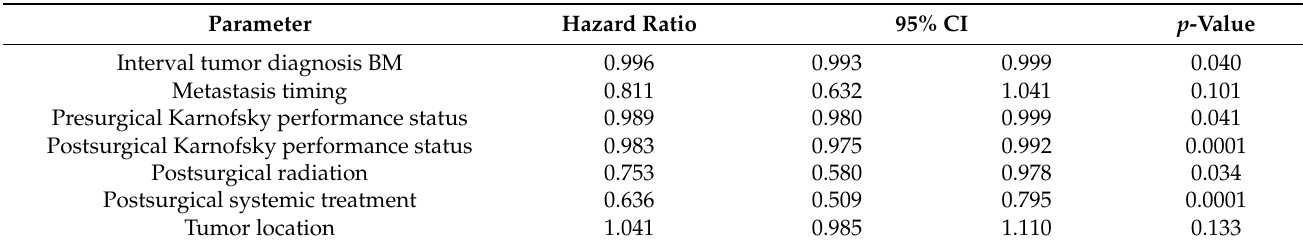
Table 4. Cox proportional hazard regression analysis shows pre and even more pronounced the postsurgical KPS, interval between tumor diagnosis and brain metastases (BM) detection, adjuvant radiation and systemic treatment as independent prognostic factors for overall survival in the elderly